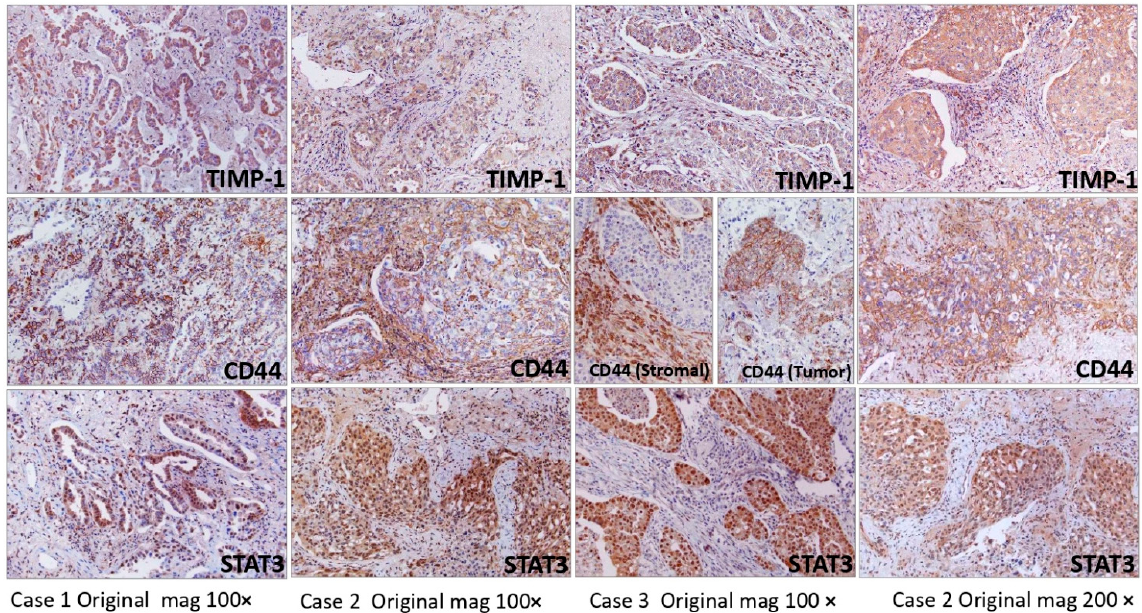
Figure 6. Formalin-fixed, paraffin-embedded surgical pathology specimens from three randomly selected patients with a diagnosis of NSCLC. Sections were immunoreacted with anti-TIMP-1, anti- CD44 and anti-STAT3. Original magnification 100× (first three columns) and 200× (last column).